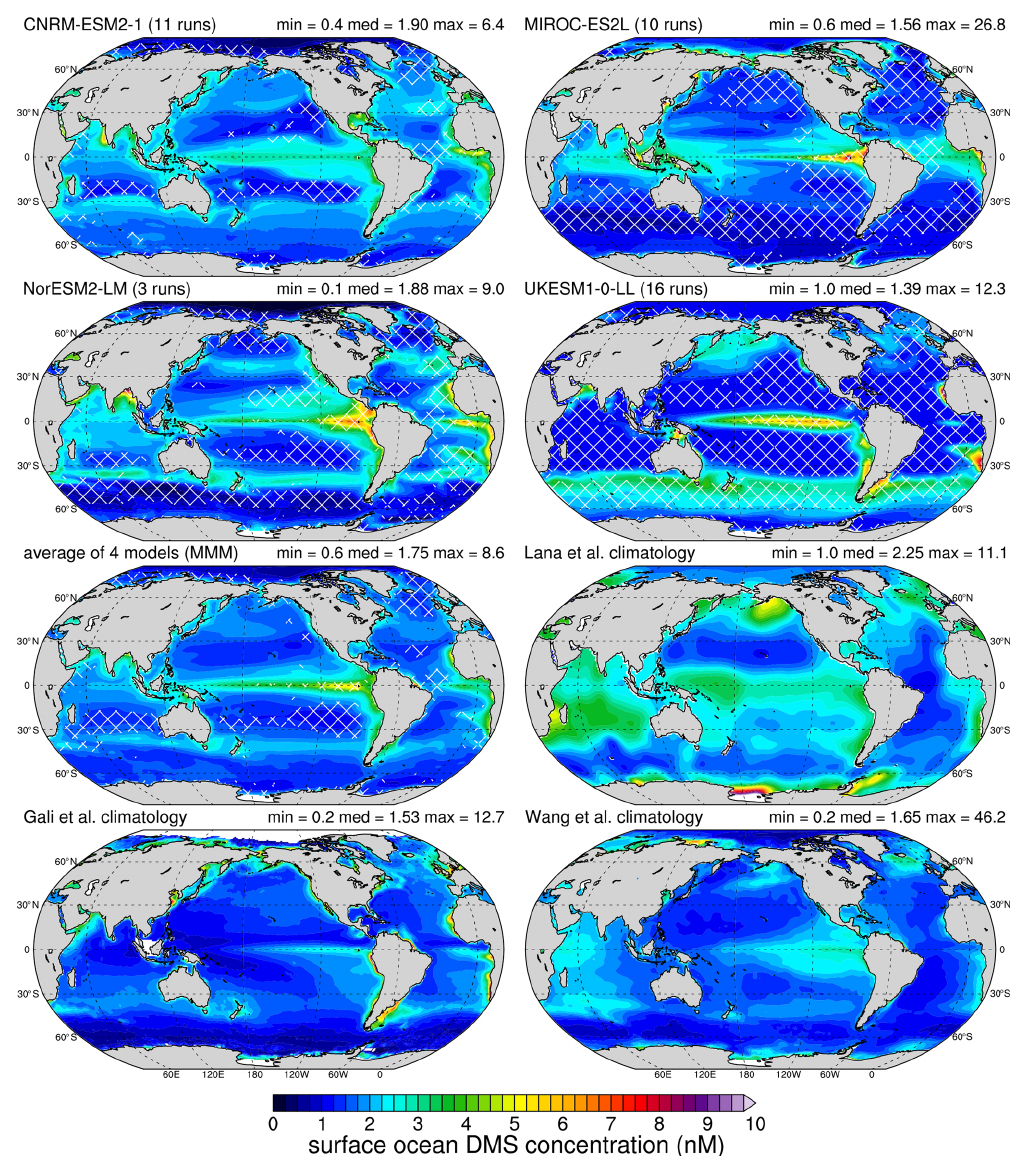
Figure 1. Mean (1980–2009) surface ocean DMS concentration (nM) for the CMIP6 historical experiments of the four models: CNRM- ESM2-1, MIROC-ES2L, NorESM2-LM, UKESM1-0-LL, and the MMM. Annual means of L11, G18, and W20 are also plotted. Minimum, area-weighted median, and maximum from each model or data product are also displayed. Hatching on the model plots shows locations where the DMS concentration is outside the range covered by L11, G18, and W20 (see text for